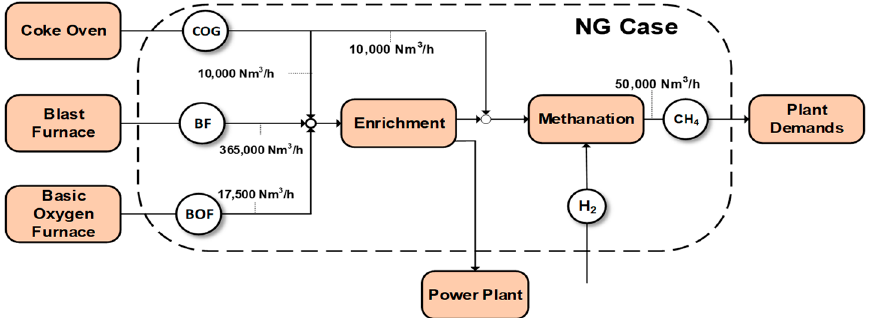
Figure 2. The NG case: replacement of natural gas demands of the steel plant.